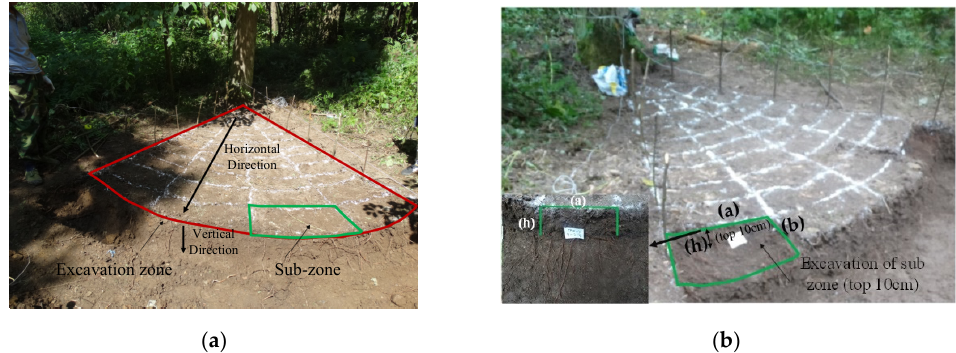
Figure 3. ( a ) Excavation zone marked on the ground with white chalk powder, ( b ) incremental excavation (depth of each increment (h) was 10 cm for each